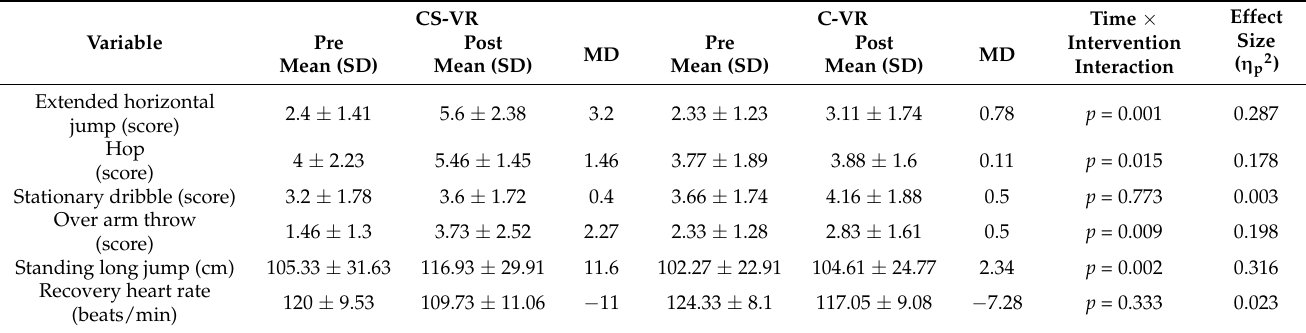
Table 10. Changes of performance variables in response to CS-VR and VR (mean ±